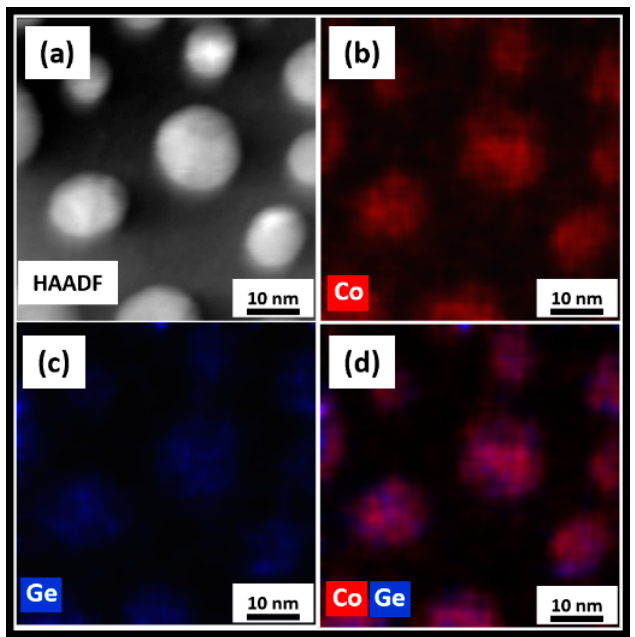
Figure 9. Scanning transmission electron microscope (STEM) studies on the as-made Co 2 Ge NPs: ( a ) A high-angle annular dark-field (HAADF) image and the corresponding energy dispersive spectroscopy (EDS) elemental color mappings showing; ( b ) Co; ( c ) Ge; and ( d ) Co and Ge distributions.